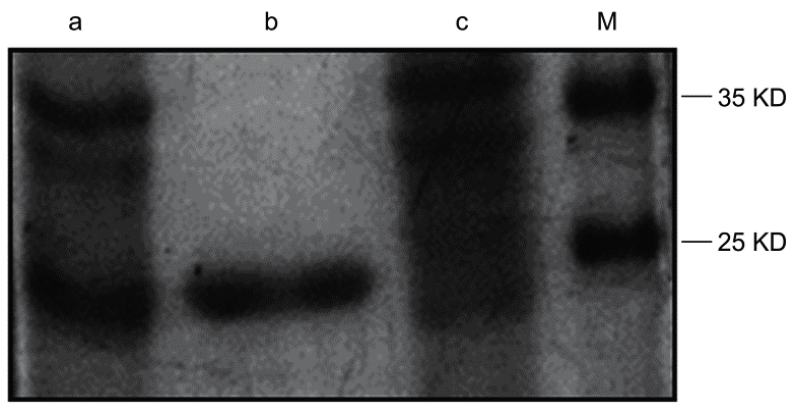
Figure 1. Detection of the purified antibody by plyacrylamide gelelectrophoresis. Lane a: lysate of induced recombinant vector; lane b: the purified Fab; lane c: supernatant of sonicated lysate after purification; lane M: protein